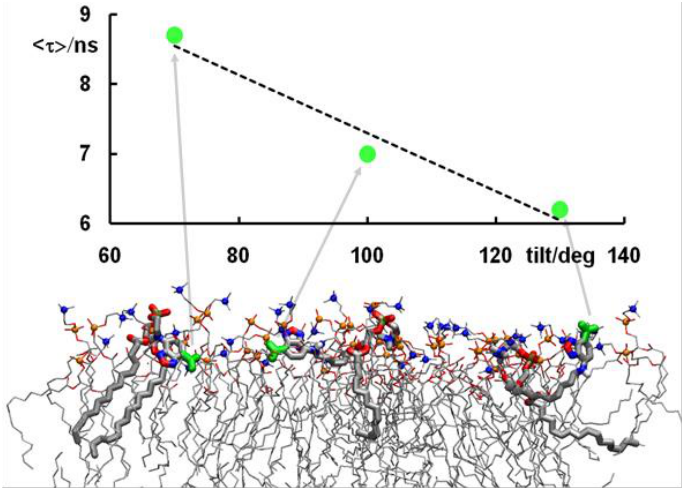
Figure 5. Intensity-averaged lifetimes 〈 τ 〉 obtained for different NBD probes in fluid PC bilayers, represented as a function of their most probable tilt of the NBD NO 2 group relative to the bilayer plane, determined by MD simulation. Representative configurations (with the NO 2 group highlighted in green) are shown to illustrate the preferred orientation of the different probes. N- NBD-DPPE, with its inward NO 2 configuration (tilt angle <90 , left) has the longest average lifetime, whereas the opposite is observed for C 12 NBD-PC, in which the NO 2 group is oriented towards the water medium (tilt angle >90 , right). An intermediate situation is observed for C 6 NBD-PC (center). Reprinted from [69] with permission from the PCCP Owner Societies.